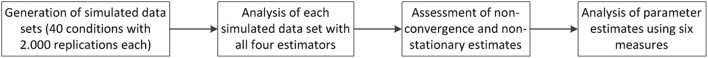
Flowchart of the study design of the simulation study.